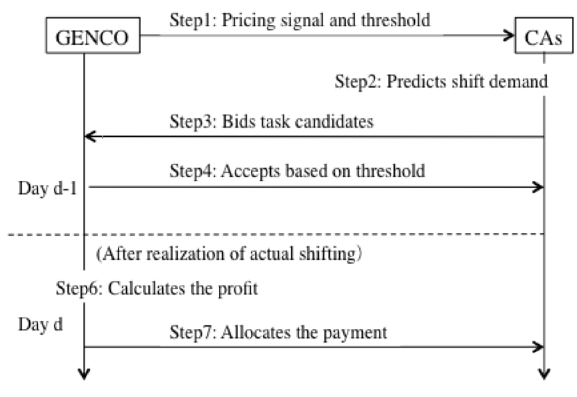
Fig. 3. Singleton model